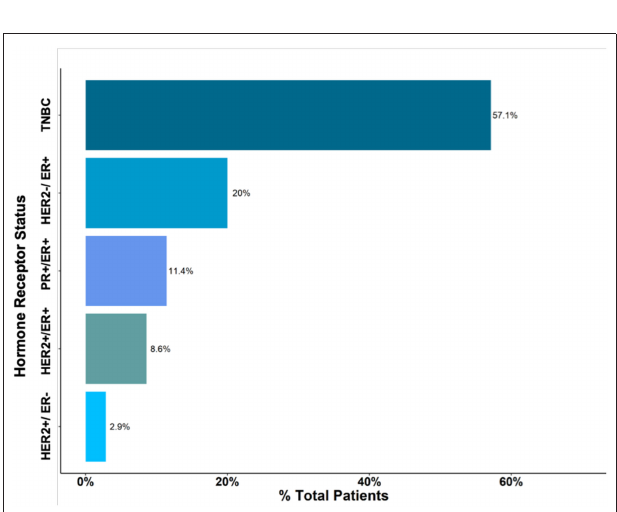
FIGURE 3 | Histological type of Breast Cancer. Triple-Negative Breast Cancer (TNBC) accounted for approximately 57% of